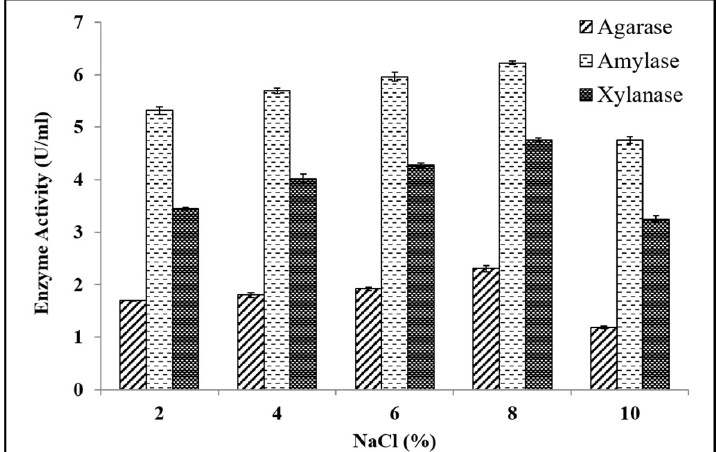
Figure 4. Effect of different concentrations of NaCl on production.